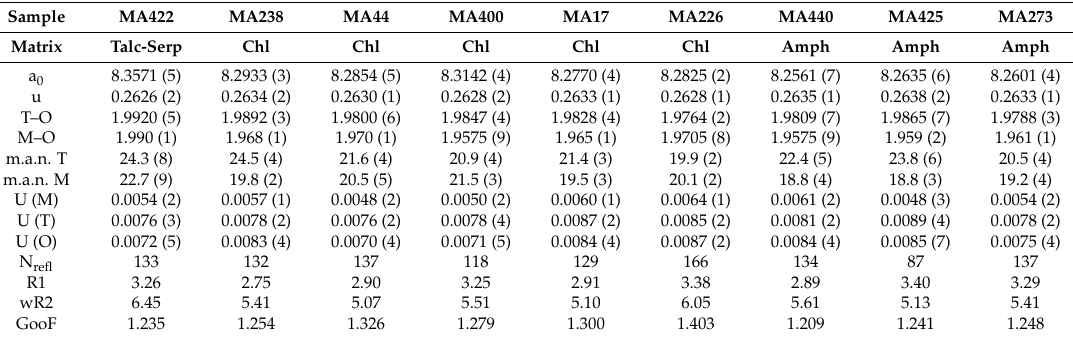
Table 1. Results of structure